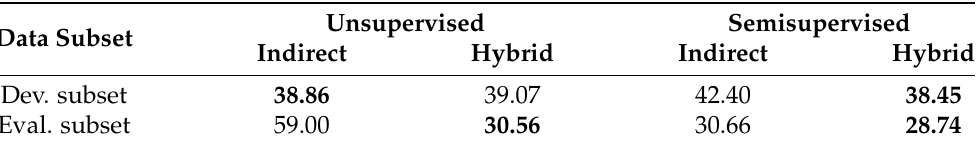
Table 4. AER (%) results for the Albayzín 2020 corpus for the assisted configuration. Results from indirect assignment and hybrid systems, including results for both development and test subsets. Experiment corresponds to an open-set